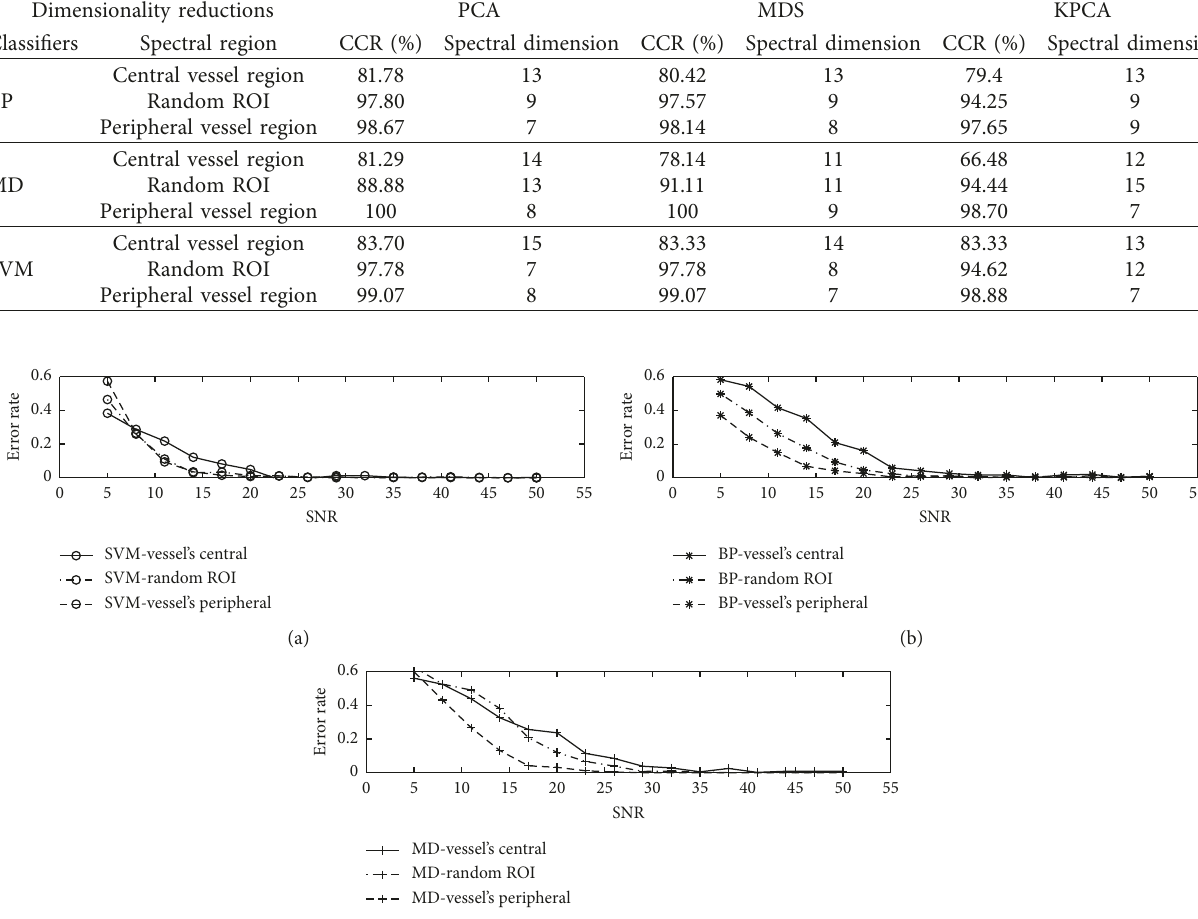
Figure 12: Different SNR with error rates: (a) SVM; (b) BP; (c) MD.